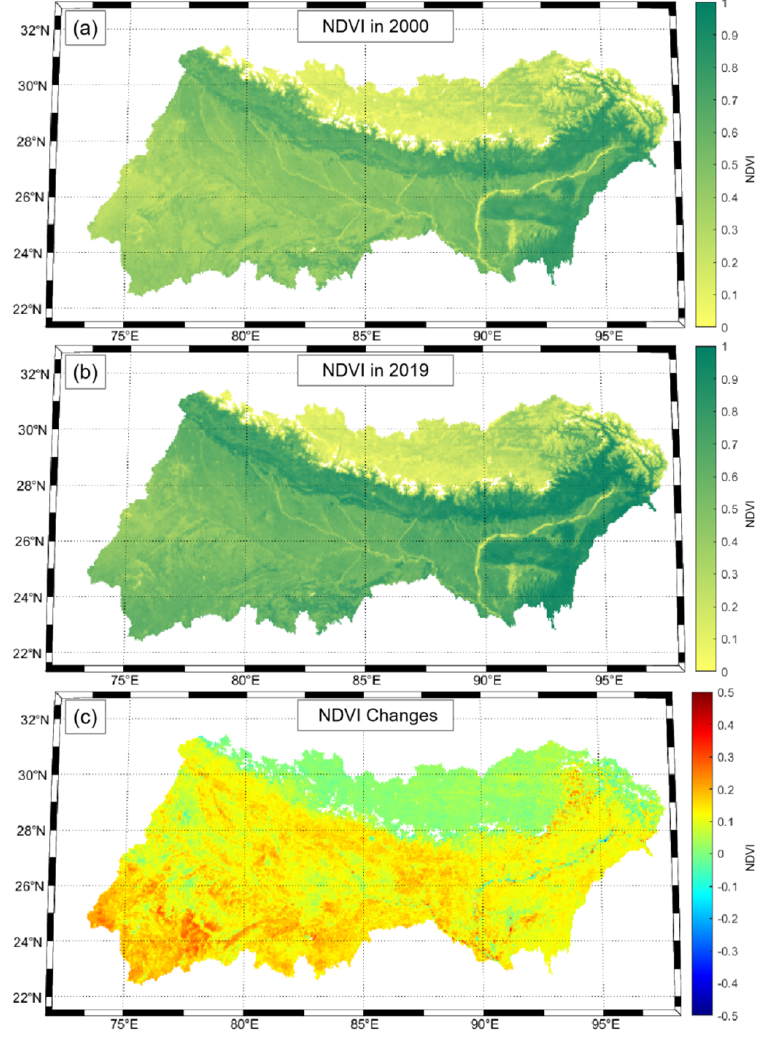
Figure 9. Mean NDVI values from MODIS for the Ganges–Brahmaputra River Basin. ( a ) Mean NDVI value for the river basin in 2000. ( b ) Mean NDVI value for the river basin in 2019. ( c ) Changes in the mean NDVI value between 2000 and 2019.